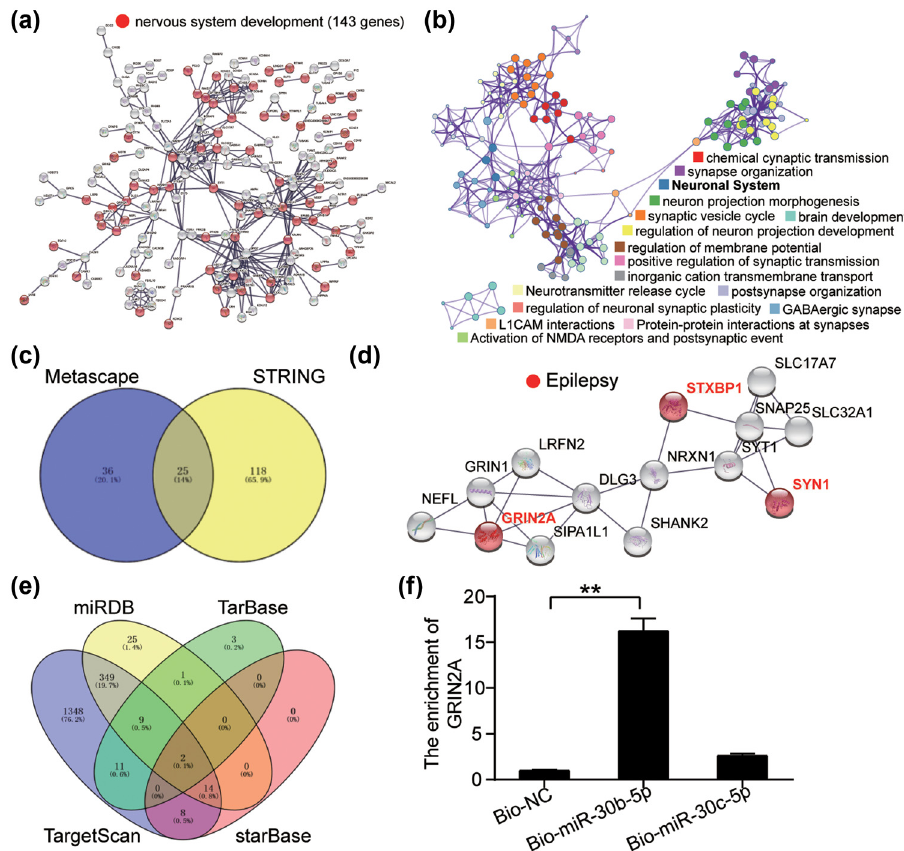
Figure 1: miR - 30b - 5p and GRIN2A were the key regulators in epilepsy. ( a ) STING was used for GO enrichment of 571 DEGs screened from GSE28674 with adj. P < 0.05. ( b ) Metascape was used for GO enrichment of 571 DEGs screened from GSE28674 with adj. P < 0.05. ( c ) Twenty - fi ve genes involving nervous system development from STRING and neuronal system from Metascape overlapped. ( d ) STXBP1, GRIN2A, and SYN1 were enriched to be related to epilepsy. ( e ) Two miRNAs were predicted to bind to GRIN2A based on the four databases ( miRDB, TarBase, TargetScan, and starBase ) . ( f ) Enrichment of GRIN2A was detected by RNA pull - down